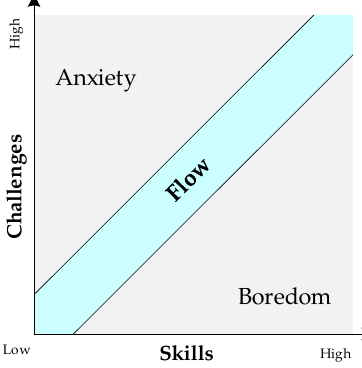
Figure 3. Flow channel according to Csikszentmihalyi. Adapted from [30].